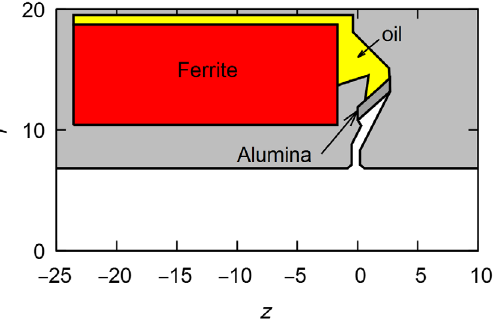
FIG. 13. Permeability data for CN20 ferrite. Measured data shown as dots, solid lines fitted data used in CHICAGO